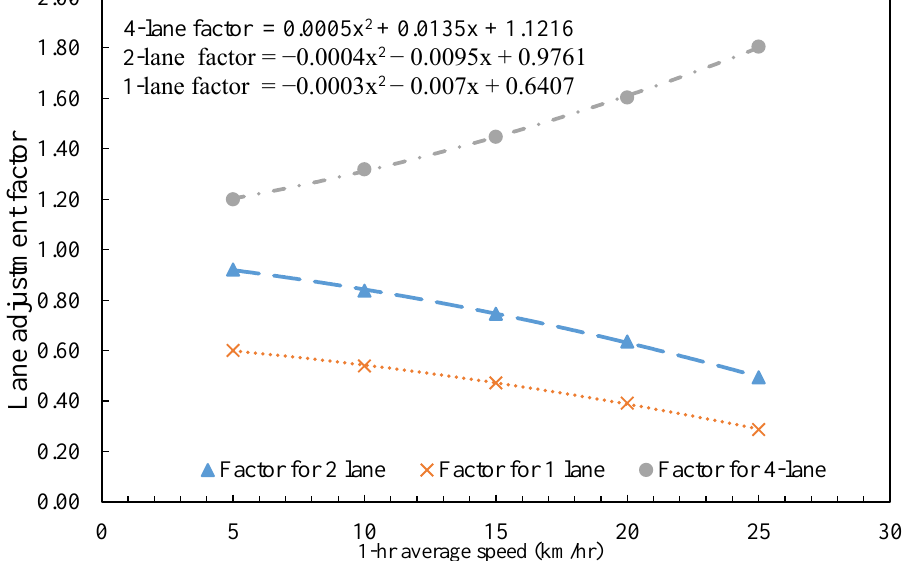
Figure 7. Adjustment factors for road with different number of lanes .